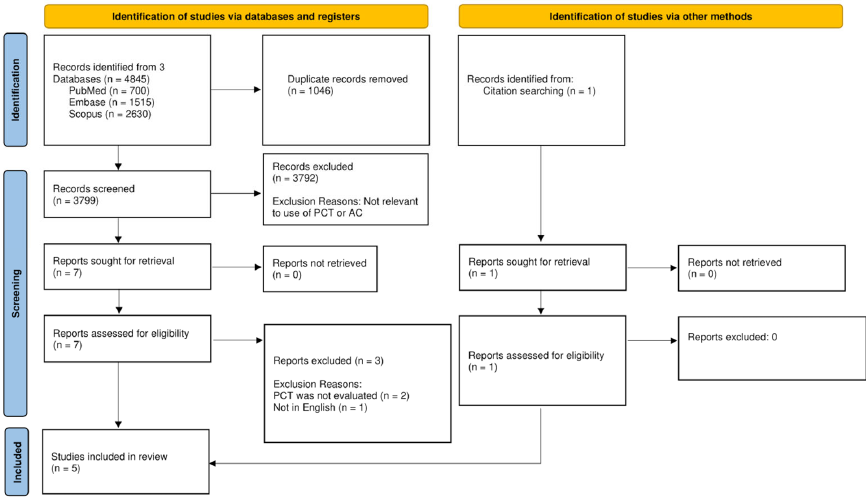
Figure 1. PRISMA